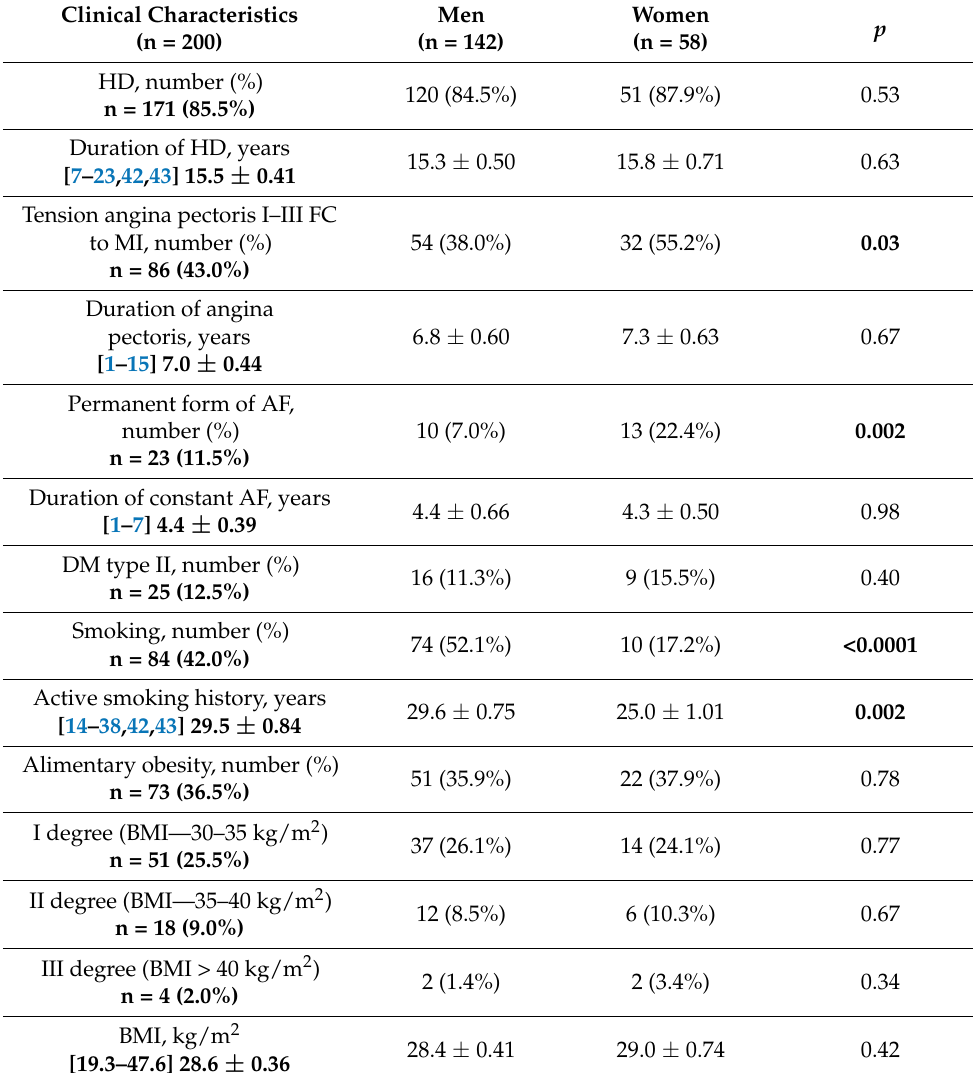
Table 2. Main clinical characteristics of NSTEMI patients on the whole by group and depending on